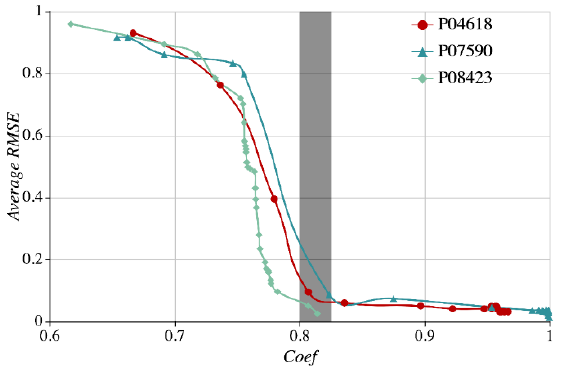
Figure 16. Impact on SAM error with the correlation coefficient thresholds. In Figure 16, the horizontal and vertical axes represent the correlation coefficient ( Coef ) and the average RMSE, the legends of the solid circle, triangle, and rhombus correspond to the nodes P04618, P07590, and P08423, respectively. Overall, the average RMSE